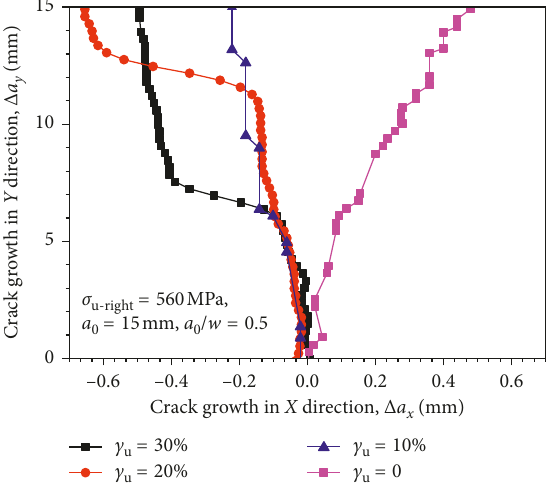
Figure 8: Crack extension paths of ultimate tensile strength mismatch specimen.